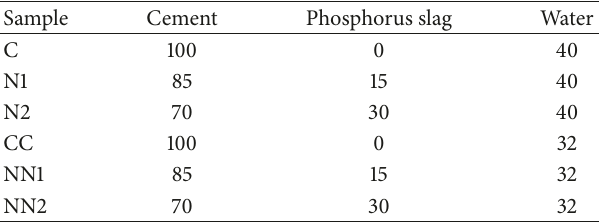
Table 3: Mix proportions of